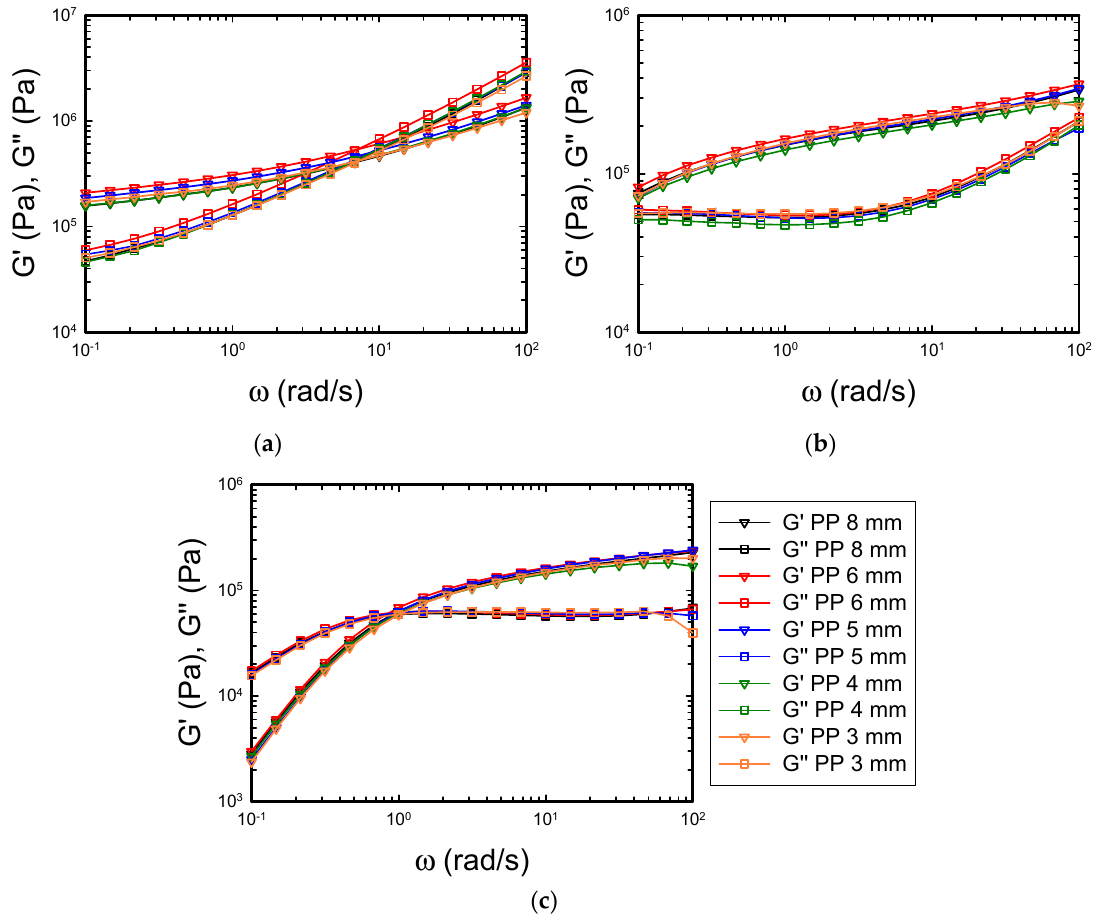
Figure 2. Dynamic frequency sweep tests on PS200k performed with different plate diameters as reported in the legend: ( a ) T = 130 °C, ( b ) T = 150 °C, ( c ) T = 170 °C. The color legend applies to the three panels.